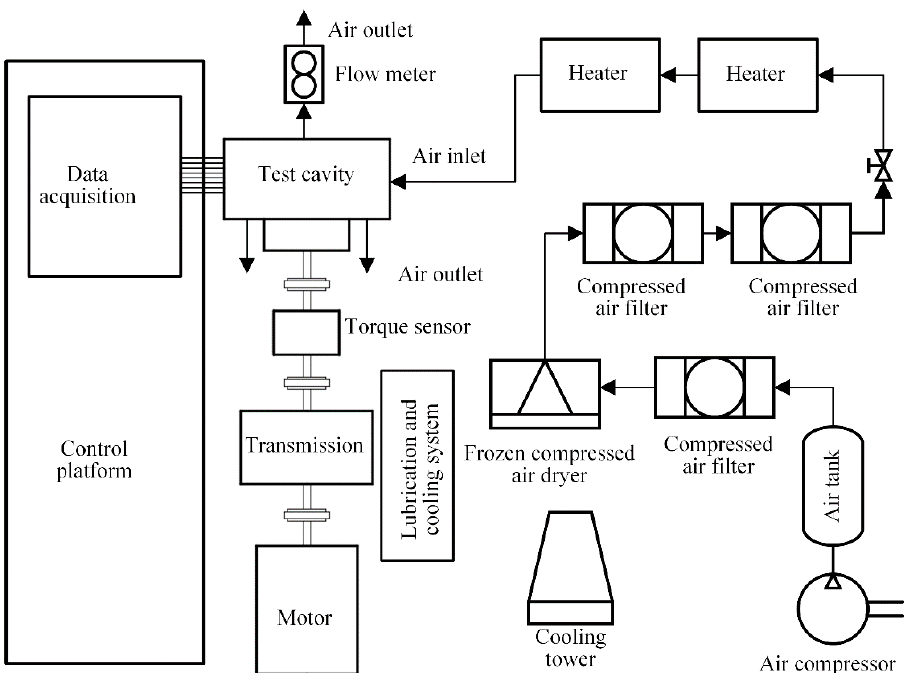
Appl. Sci. 2021 , 11 , 2239 Figure 7. Layout of the High ‐ Temperature, Ultra ‐ High ‐ Speed Sealing Test Rig. Figure 7. Layout of the High-Temperature, Ultra-High-Speed Sealing Test Rig.